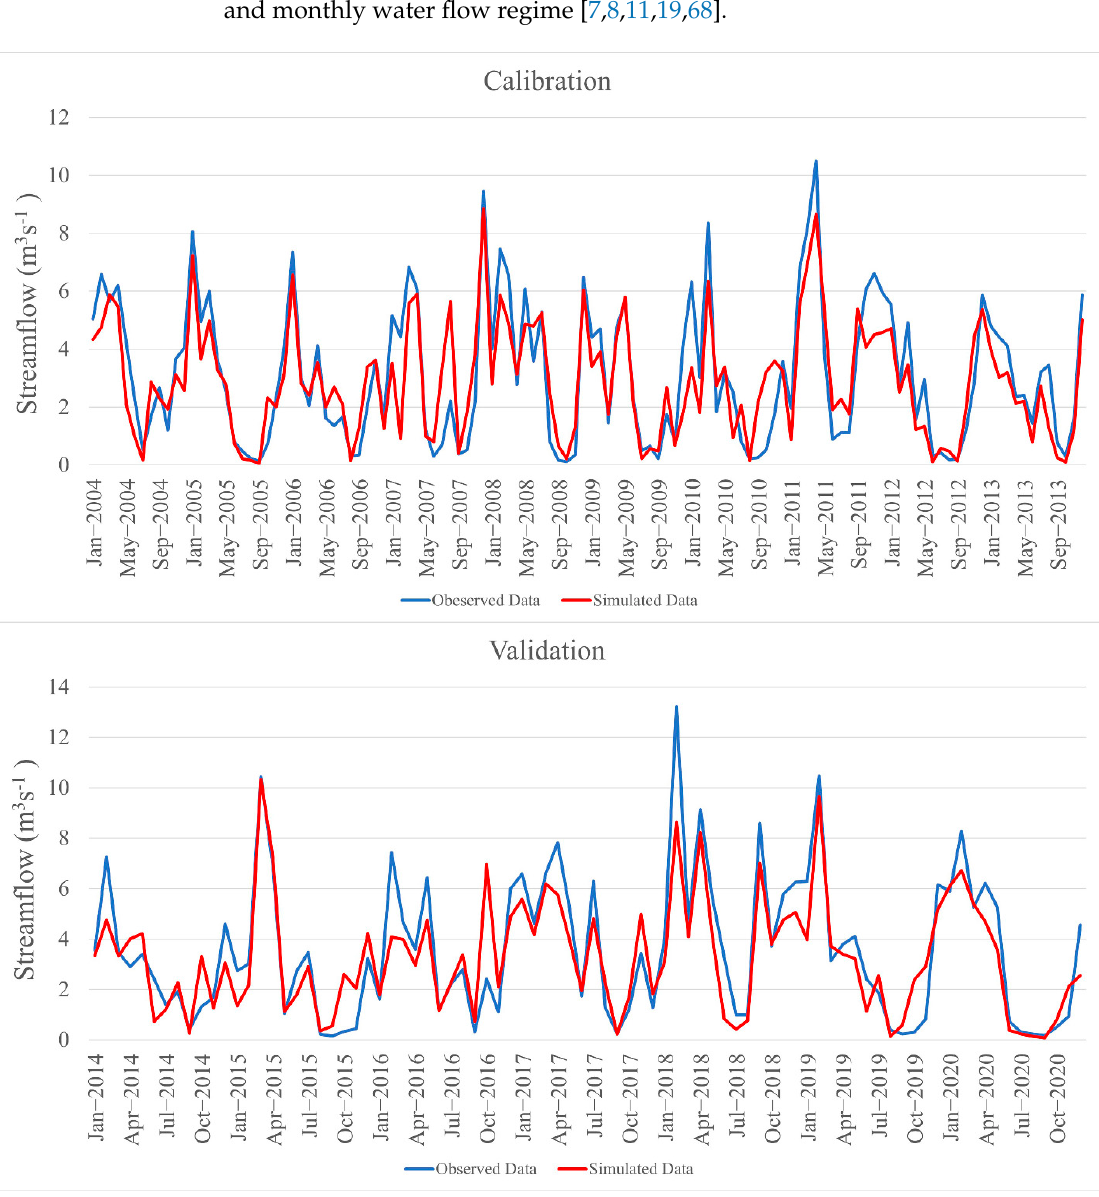
Table 4. Goodness-of-fit statistics for the monthly streamflow at the US Geological Survey (USGS) flow gauging station at Deckers Creek Watershed, Morgantown, West Virginia, USA. Note(s): R 2 = Coefficient of Determination; NSE = Nash-Sutcliffe Efficiency; PBIAS = Percent Bias.